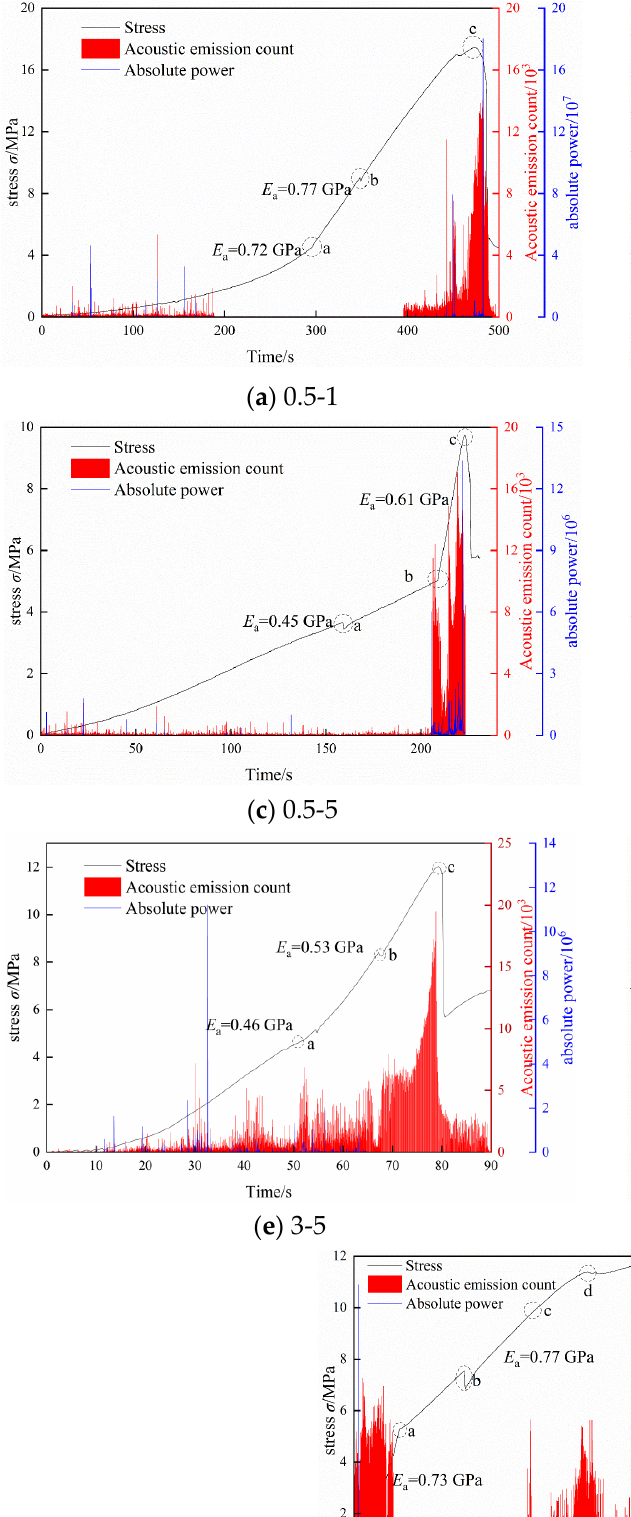
Figure 10. Comparison diagram of stress – strain in elastic stage of velocity line after same sudden change speed. At low loading rate stage, AE count is generally low, while at high loading rate stage, AE count is generally high. From high rate to low rate, the AE counting image presents a “ U ” shape or a “ W ” shape. This is because the AE signal is at a high value in the early high-rate loading. When the crack development stage reaches, the rapid crack development will also lead to the